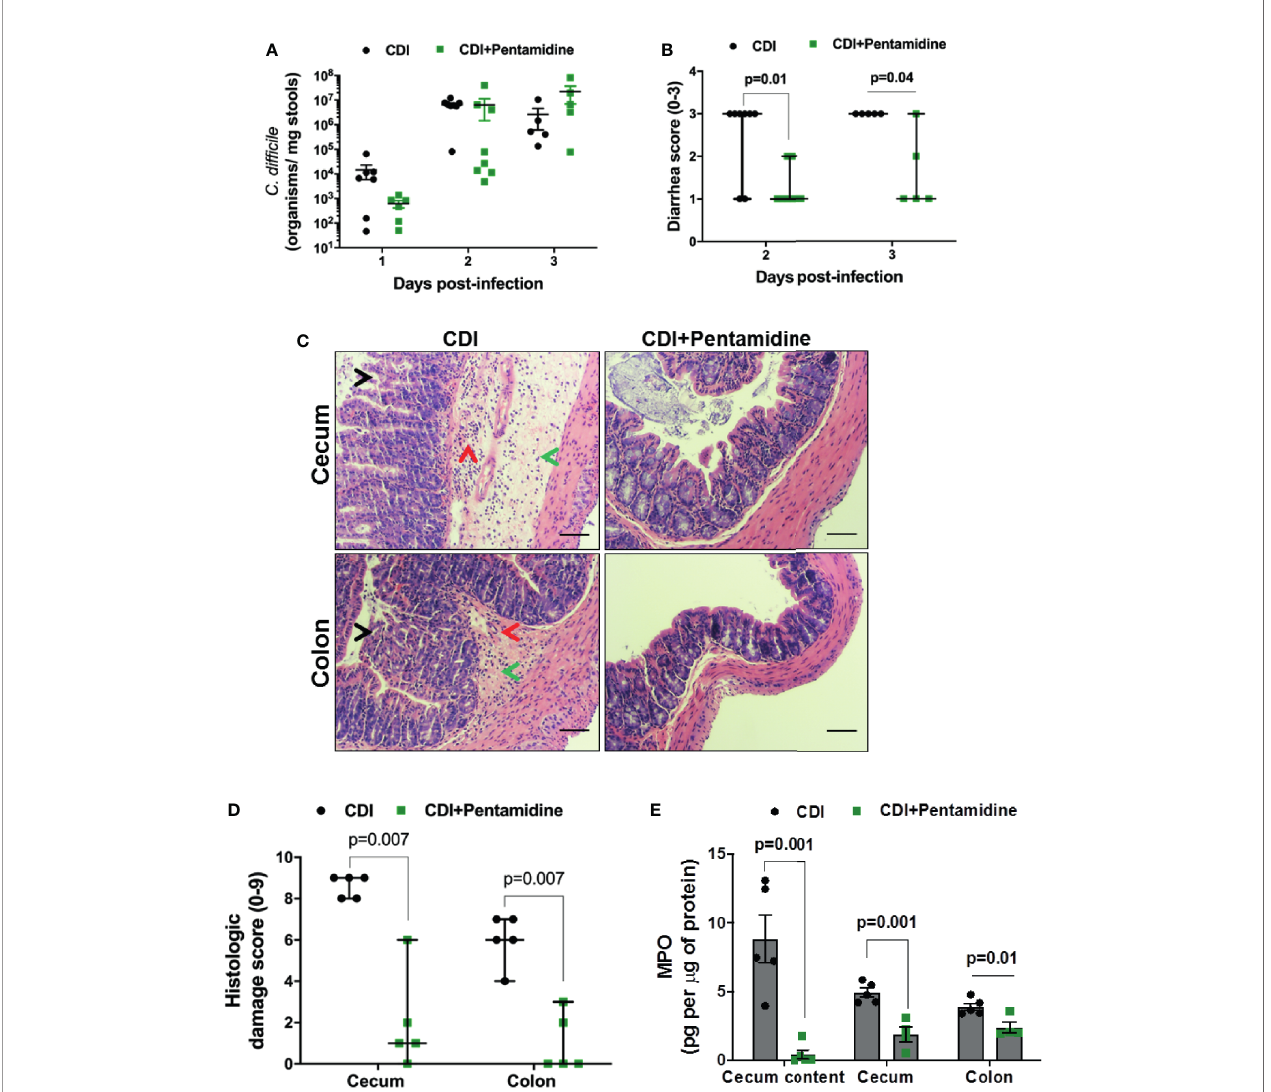
FIGURE 2 | S100B inhibition decreases diarrhea severity, intestinal damage, and neutrophil recruitment during CDI in mice. Mice were infected with 10 5 vegetative C. dif fi cile (VPI10463 strain) and treated with a S100B inhibitor, pentamidine (40 mg/kg, i.p., once daily for 3 days, CDI+pentamidine group) or non-treated (CDI group). (A) Quanti fi cation of C. dif fi cile shedding (mean ± s.e.m.) in stools by amplifying the tcdB gene by qPCR. Unpaired two-tailed Student ’ s t test. (B) Diarrhea score (median ± s.d) of CDI and CDI+pentamidine mice. Two-tailed non-parametric Mann – Whitney U-test. (C) Representative H&E stains of cecal and colonic tissues collected from CDI and CDI+pentamidine mice at day 3 postinfection (p.i.). CDI promotes damage of colonic and cecal epithelium (black arrow), edema (green arrow), and in fl ammatory cell in fi ltration (red arrow) in mice infected by C. dif fi cile (CDI group). Scale bars, 100 µm. (D) Histopathologic score (median, 0-no damage, and 9-intense damage) based on epithelial damage, submucosal edema, and in fi ltration of in fl ammatory cells. Two-tailed non-parametric Mann – Whitney U-test. (E) MPO levels (mean ± s.e.m.) in cecum content, cecum, and colon samples from CDI and CDI+pentamidine mice at day 3 p.i. measured by ELISA. Unpaired two-tailed Student ’ s t